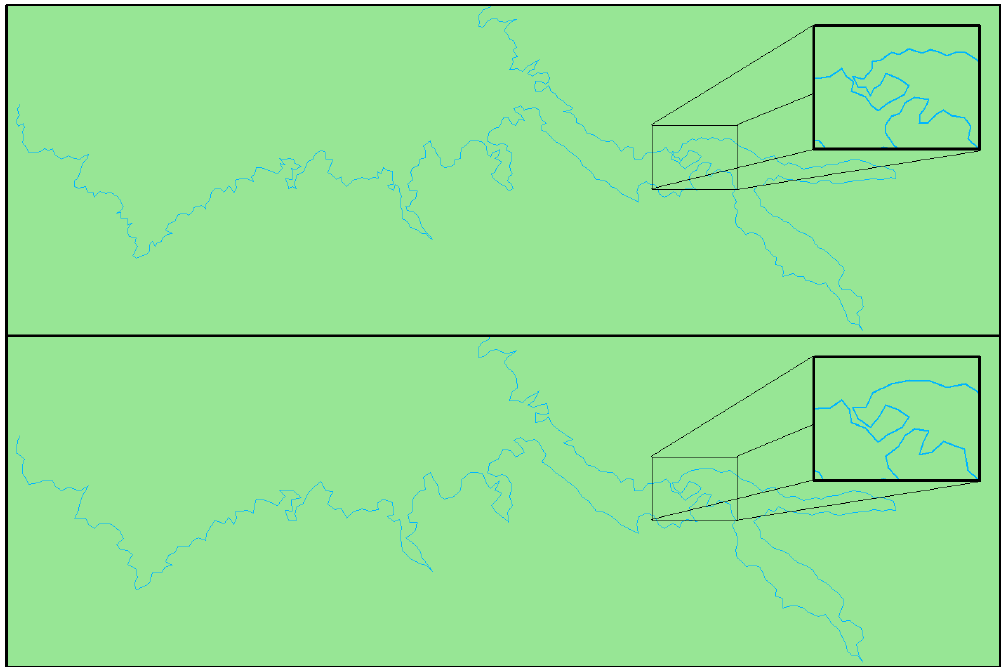
Figure 1. Line feature simplified to 1:250,000 scale: ( Top ) simplification without P c ; and ( bottom ) including P c = 1.48. Windows on the right have 2× zoom to 1:125,000 scale. Table 4. Comparison of the vertices and segments of the lines simplified with and without perception coefficient P c .